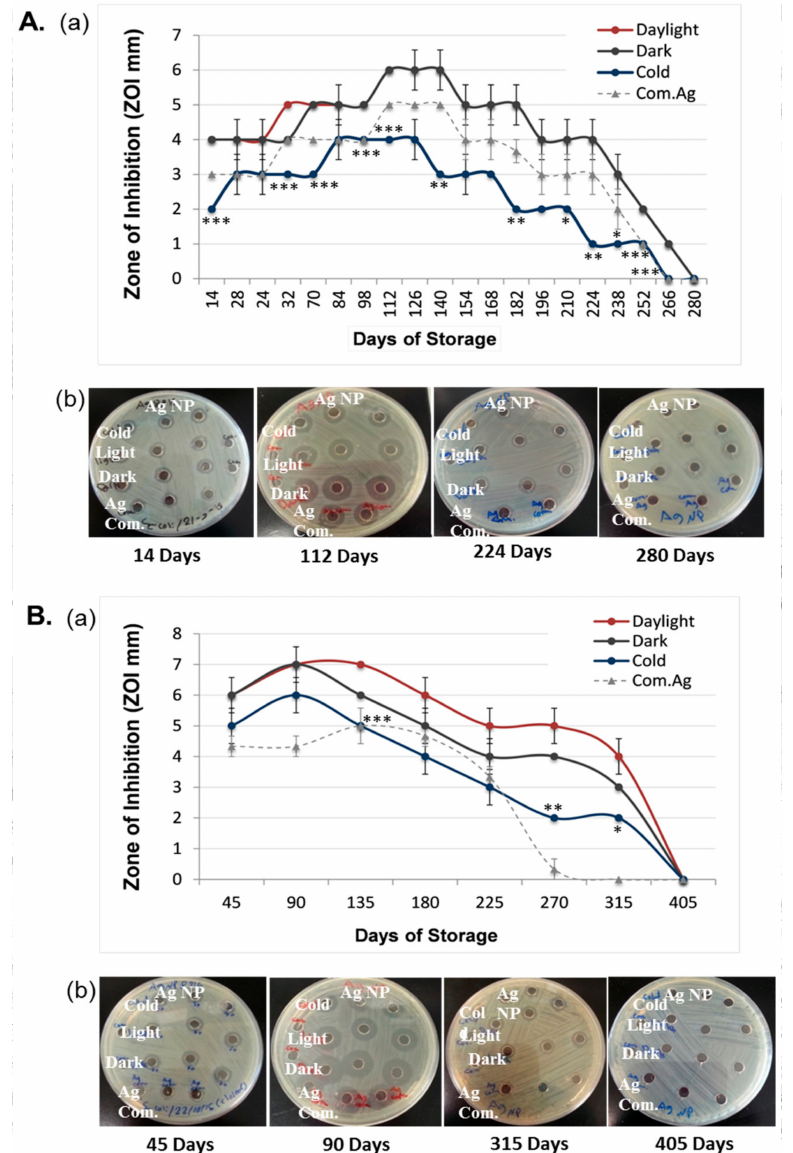
Figure 1. Antibacterial duration of laser generated silver nanoparticles (AgNPs). Samples of laser generated AgNPs were stored under three different conditions: light, dark, and cold. The antibacterial activities of the NPs were measured using the well-diffusion method every 14 days (A, the Open-14 samples) or every 45 days (B, the Open-45 samples). A thin layer of E. coli bacterial cells were grown on Muller–Hinton agar plates and then six-millimeter wells were created through the agar. Fifty microliters of laser AgNPs concentration (50 µ g/mL) were added to each well in triplicate. The plates were incubated at 37 ◦ C for 24 h. Zones of inhibition (ZOI) were measured ( Ab and Bb ) and plotted against days of storage ( Aa and Ba ). The antibacterial effects of chemically produced AgNPs that were purchased from a commercial source (Com.Ag) and stored in cold were also measured in parallel. Data are presented as mean ± SE. Compared to the samples that were measured on the same day but stored under different conditions, * p ≤ 0.05, ** p ≤ 0.01, *** p ≤ 0.001, n =